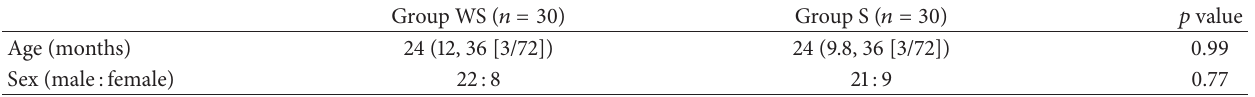
Table 1: Patient characteristics. Data are median (interquartile range